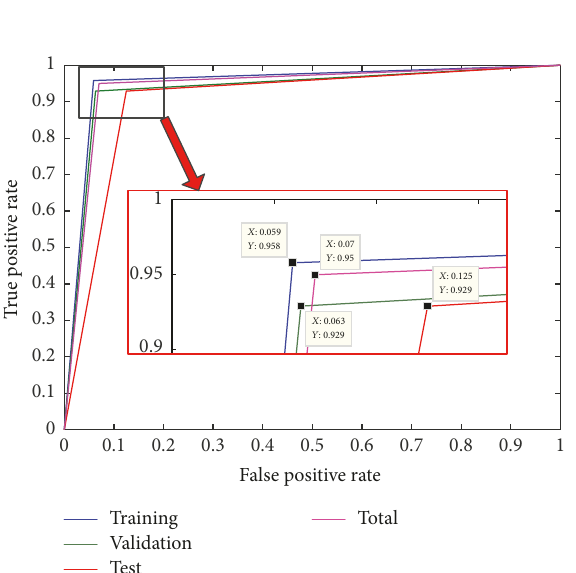
Figure 7: ROC curve of different data sets.